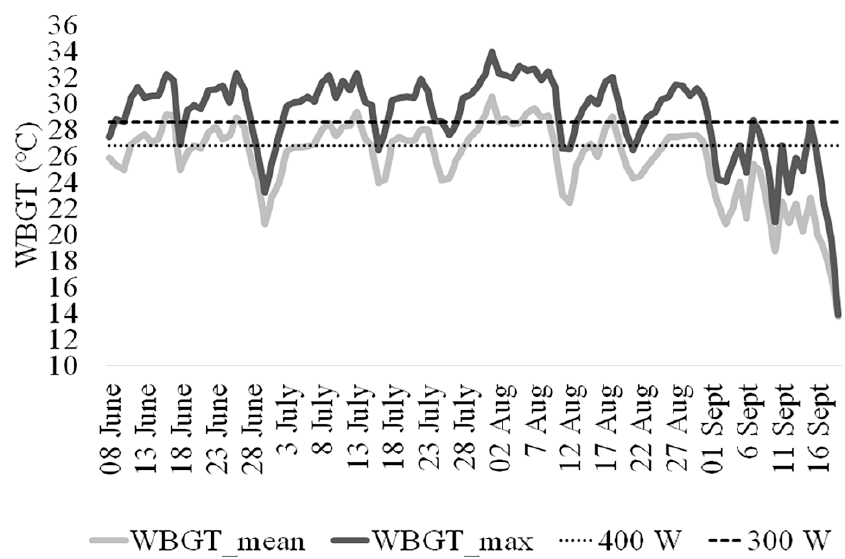
Figure 3. Mean and maximum daily Wet-Bulb Globe Temperature (WBGT) index during the working time of the day at the three work sites involved in the study, summer 2017. The dashed lines represent the WBGT ISO standard thresholds respectively for a high (400 W) and a moderate (300 W) work effort as declared by the native workers.